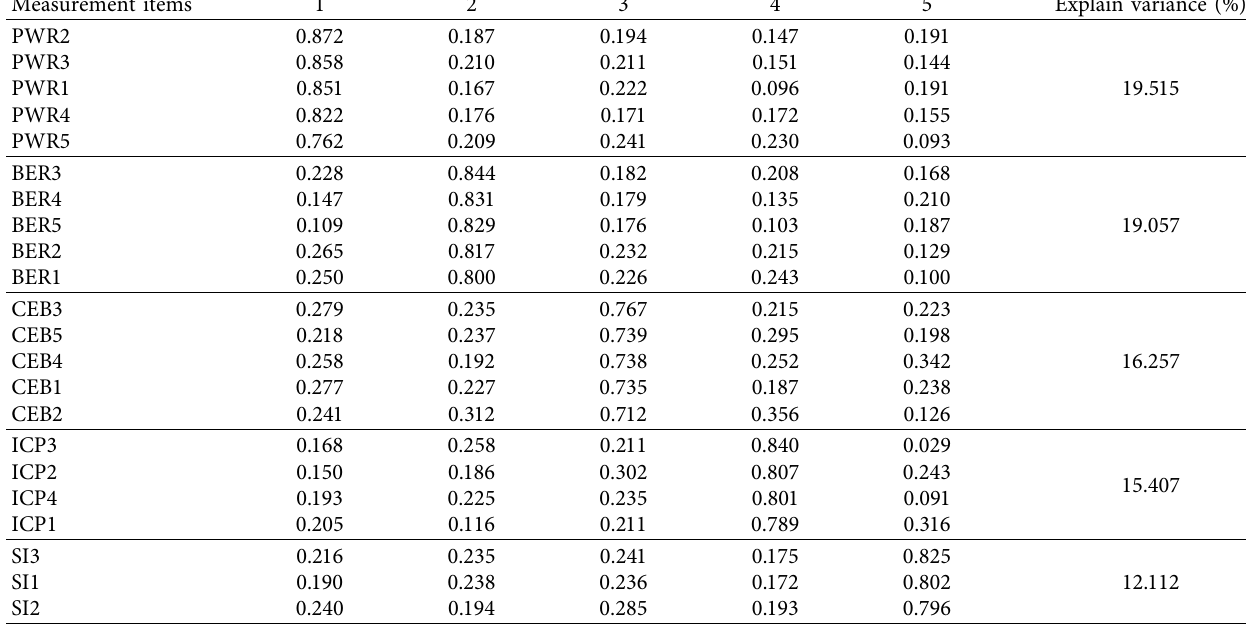
Table 4: Rotation factor matrix.